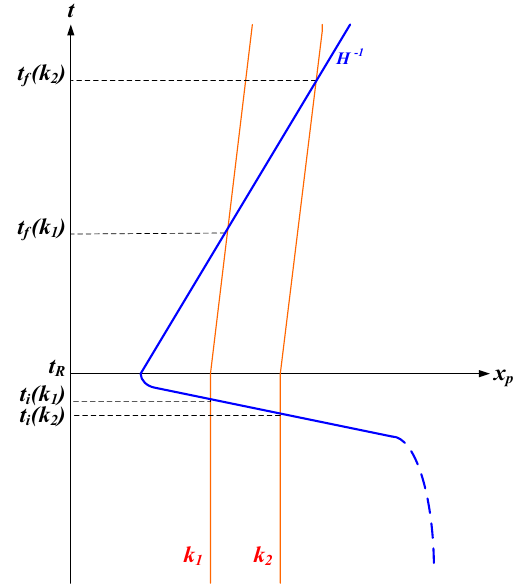
Fig. 4 Space-time sketch of the emergent universe scenario. As in Fig. 1 in the illustration of inflationary cosmology, the vertical axis indicates time, the horizontal axis physical distance. The time t R is the end of the emergent phase and the onset of the radiation phase and plays a similar role to the time of reheating t R in inflationary cosmology. The Hubble radius (the blue solid curve labelled by H − 1 ) is infinite deep in the emergent phase. The physical wavelengths of fluctuation modes (indicated by k 1 and k 2 in the graph) are constant in the emergent phase. A mode exits the Hubble radius towards the end of the emergent phase at the time t i ( k ) and re-enters in late time cosmology at the time t f ( k